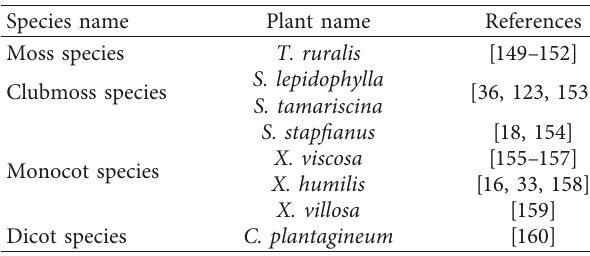
Table 3: Gene expression and EST sequencing studies on various resurrection